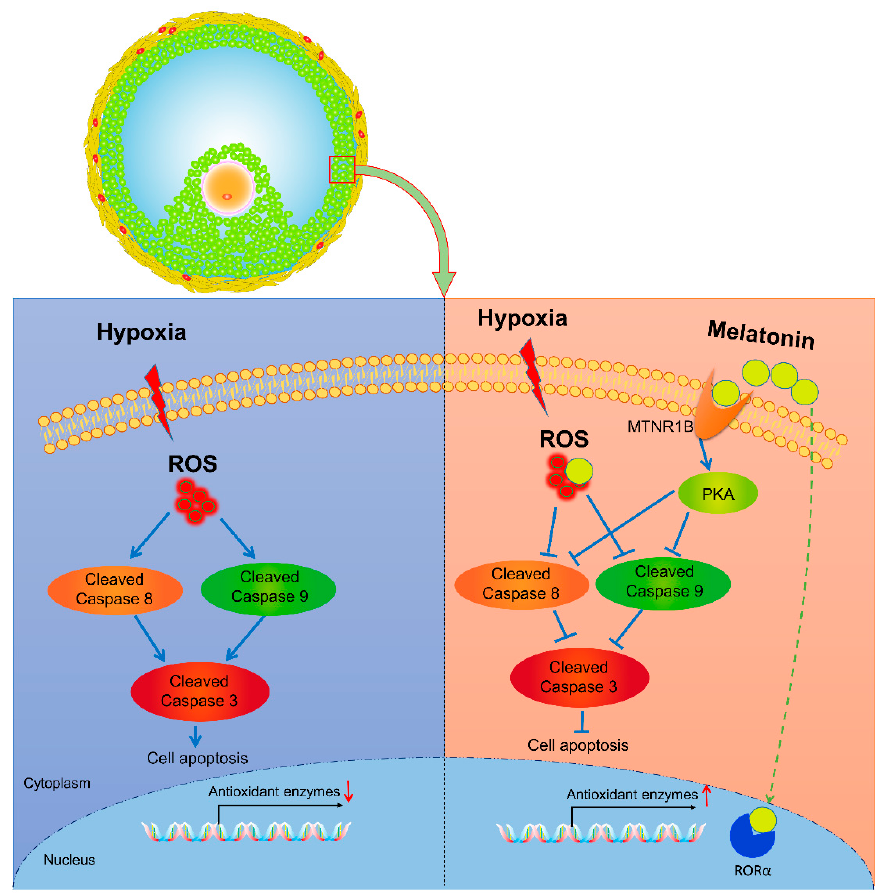
Figure 6. Schematic illustration of the signaling pathway involved in MT-mediated GCs resistance to hypoxia-induced apoptosis. Hypoxia facilitates ROS accumulation and the cleavage of the initi- ator caspases (8, 9), which in turn activates the executioner caspase 3, thereby inducing GCs apoptosis. In the presence of MT, the apoptosis of GCs is inhibited, possibly through the clearance of cellular ROS, activation of antioxidant enzymes expression, or suppression of Caspase 8/9-Caspase 3 axis via the MT–MTNR1B–PKA